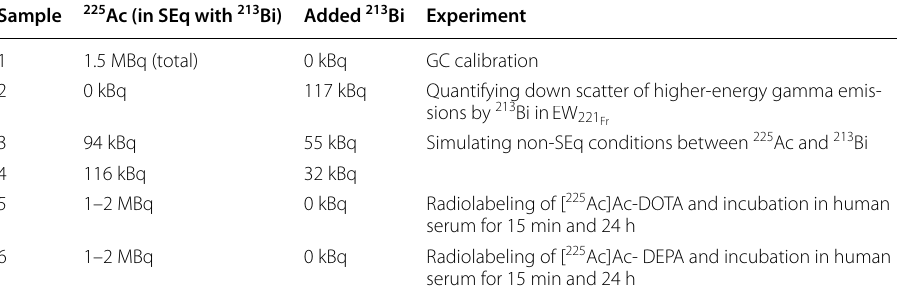
Table 1 Overview of the different samples for GC measurements and the activity at the start of the